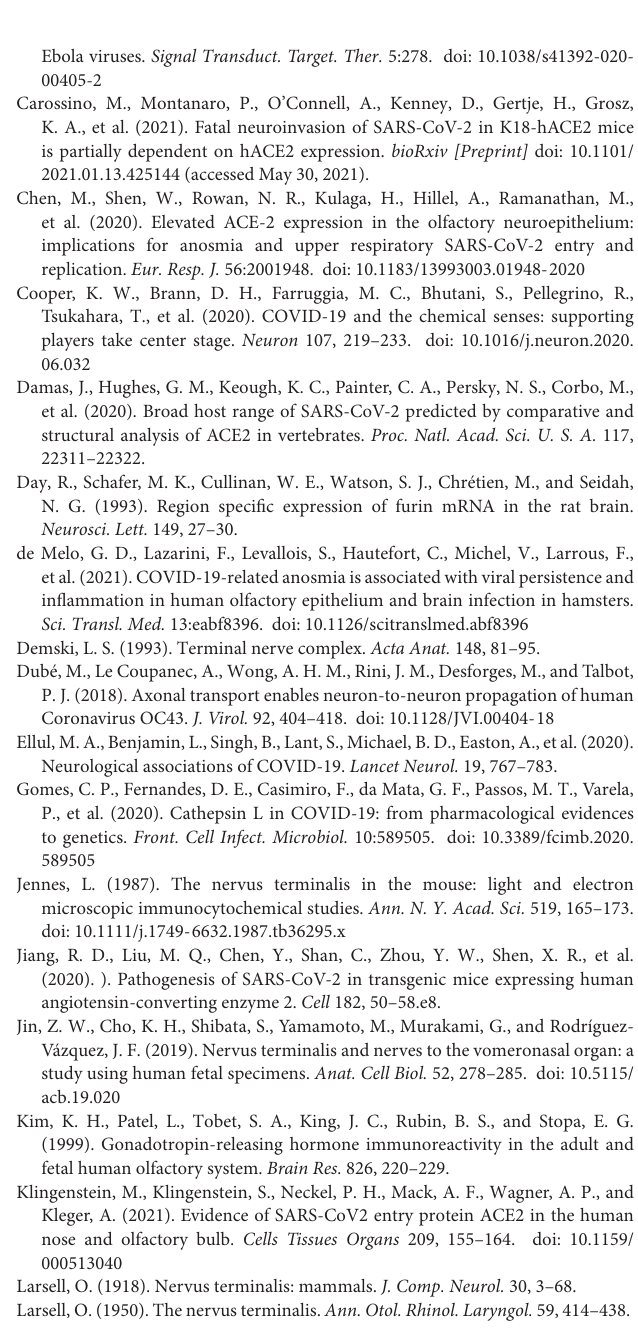
Supplementary Table 1 | Primary and secondary antibodies used in this study. ACE2, angiotensin converting enzyme 2; CHAT, choline acetyltransferase; GnRH1, Supplementary Table 2 | Numbers of animals, sections, and numbers of neurons double-labeled for nervus terminalis markers (GnRH, CHAT) and